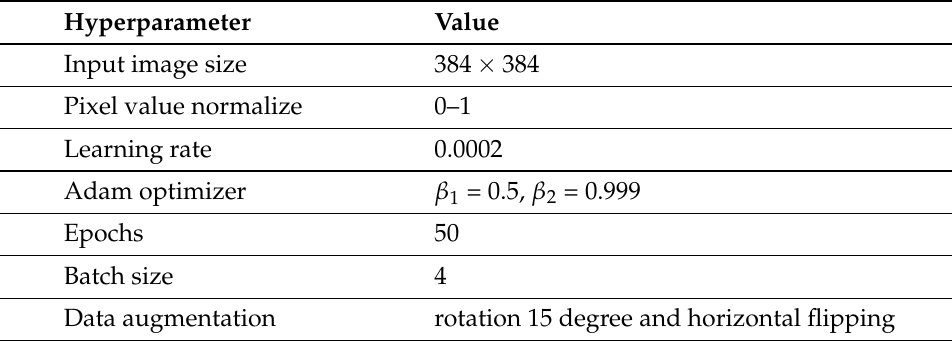
Table 2. A summary of hyperparameters.